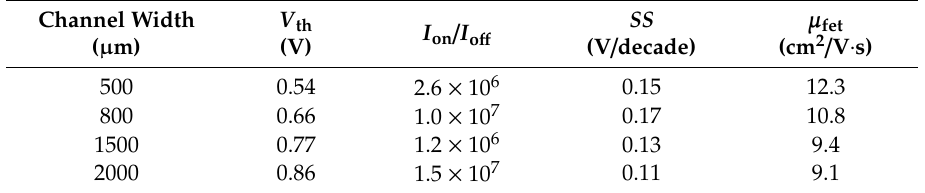
Table 3. The electrical performance parameters of a -IGZO TFT with di ff erent sizes of channel width at an oxygen flow rate of 1